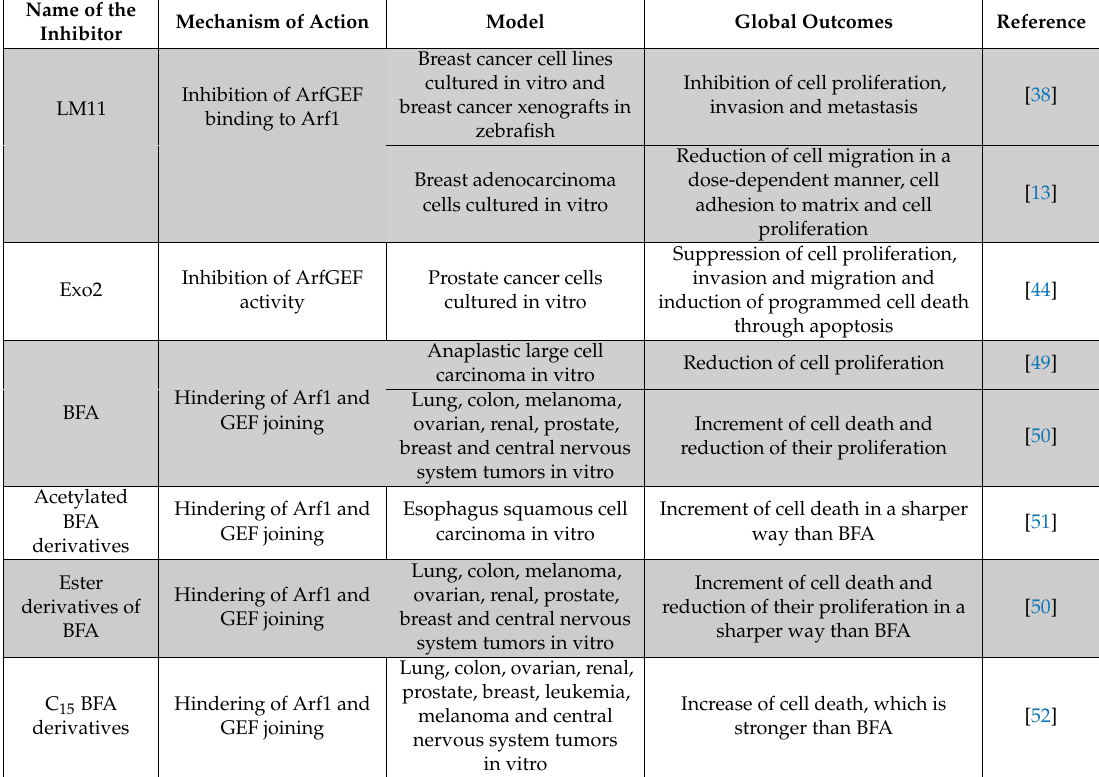
Table 1. Action of Arf1 inhibitors in cancer